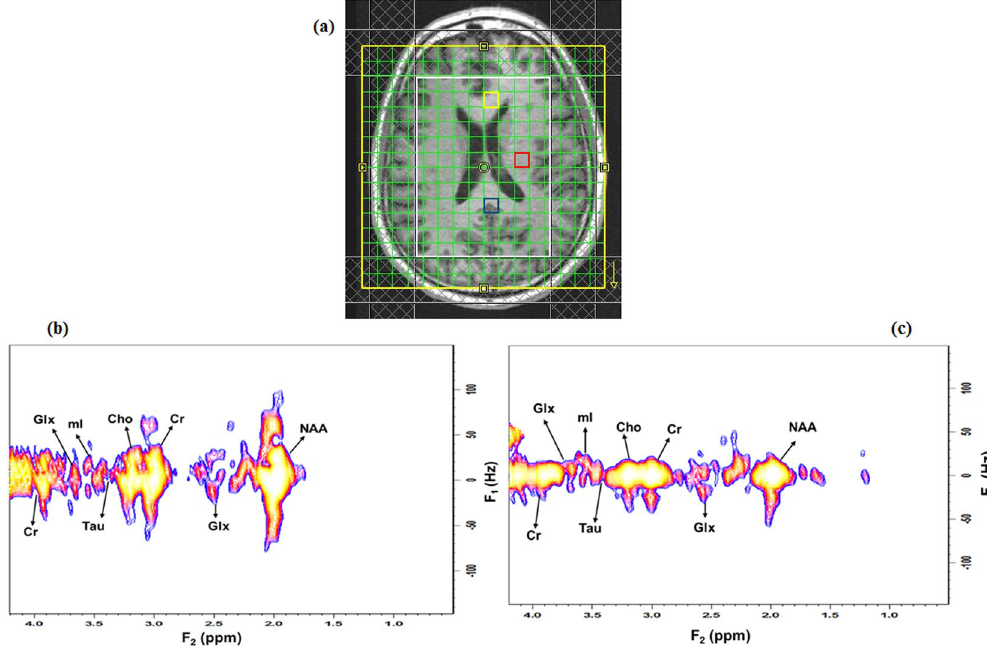
Figure 6. ( a ) T 1 -weighted axial MRI of a 59-year-old healthy brain with the white box indicating the PRESS localization, ( b ) selected 2D J -resolved spectra extracted from the mid occipital (voxel in blue) and, ( c ) mid frontal (voxel in yellow).